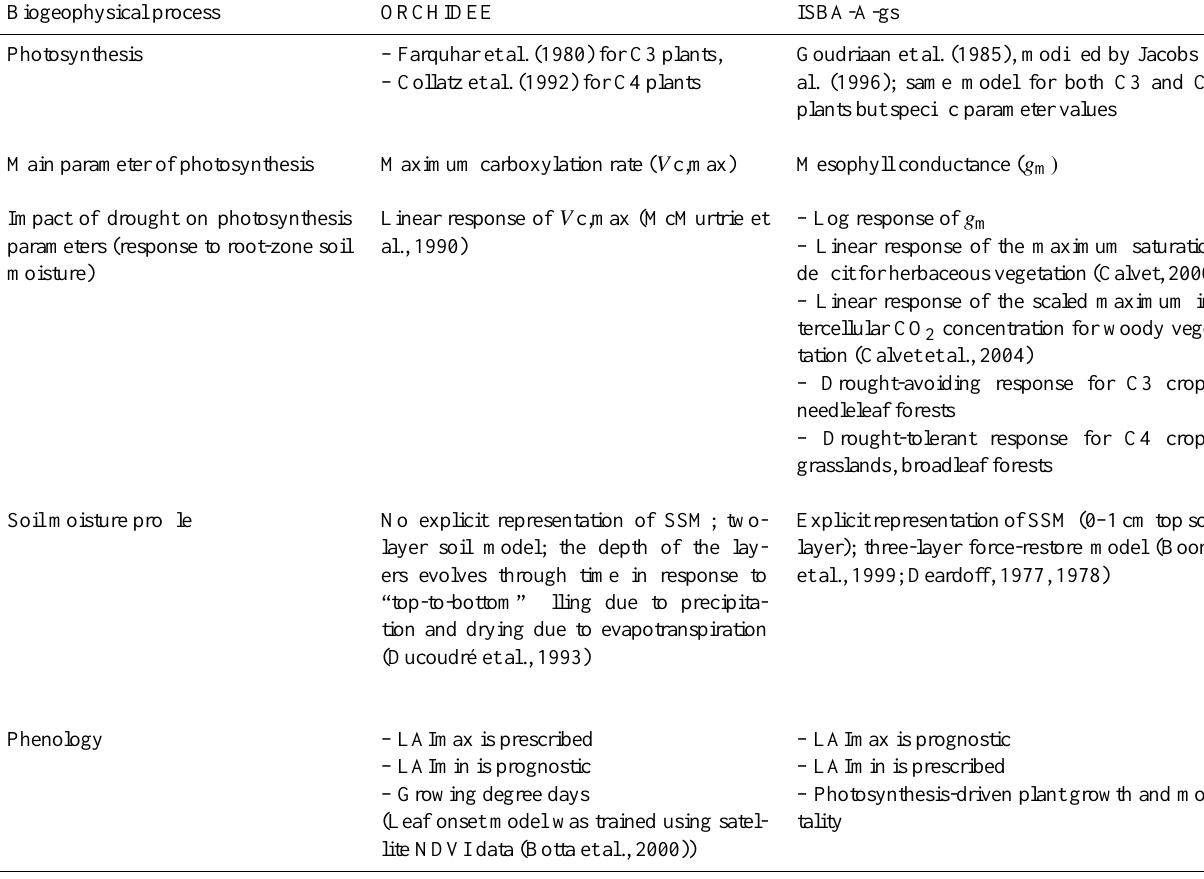
Table 1. Summary of the characteristics of the ORCHIDEE 1.9.5.1 tag and ISBA-A-gs SURFEXv6.2 configurations used in this study. Biogeophysical